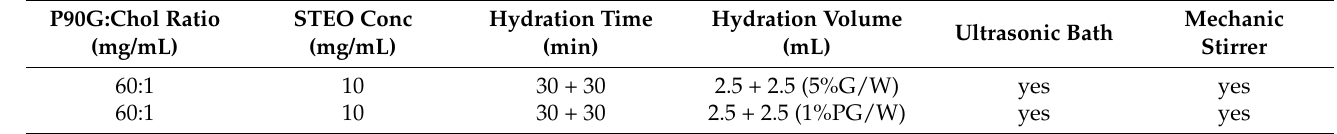
Table 9. Preparation of STEO-loaded vesicles.